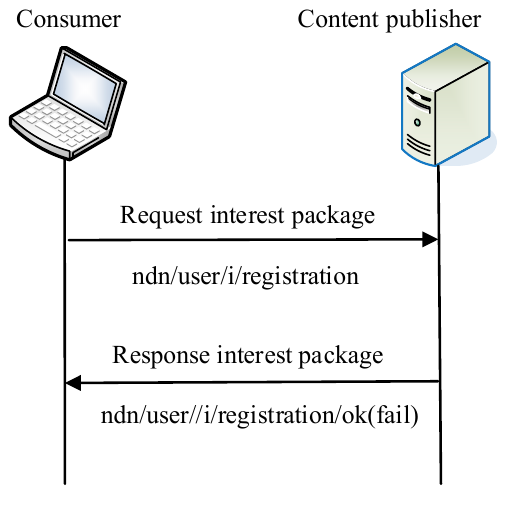
Figure 2. User registration process.